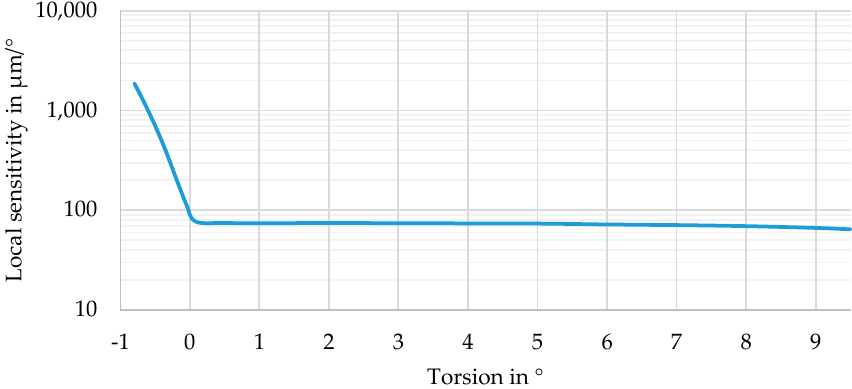
Figure 7. Local sensitivity for torsion.